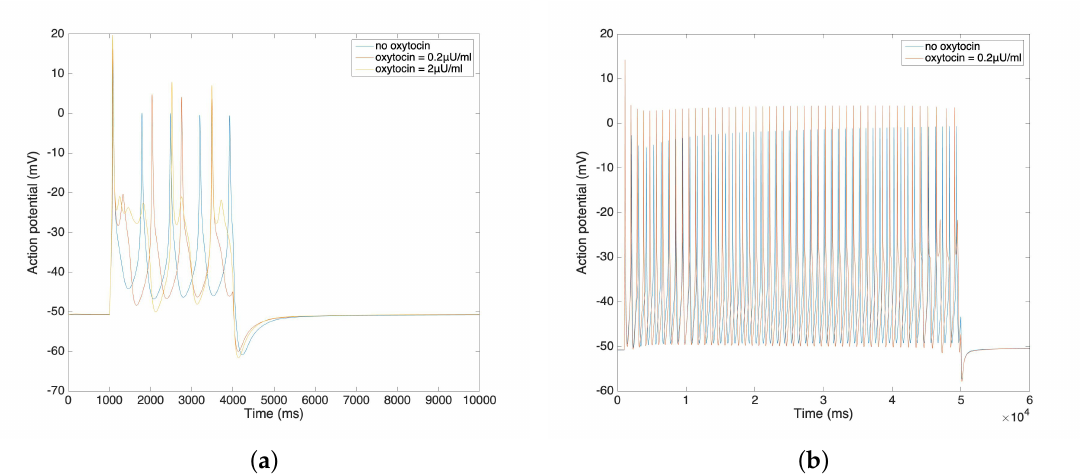
Figure 4. ( a ) Short burst action potential under the application of oxytocin at different concentrations. ( b ) Long burst action potential under the application of oxytocin.